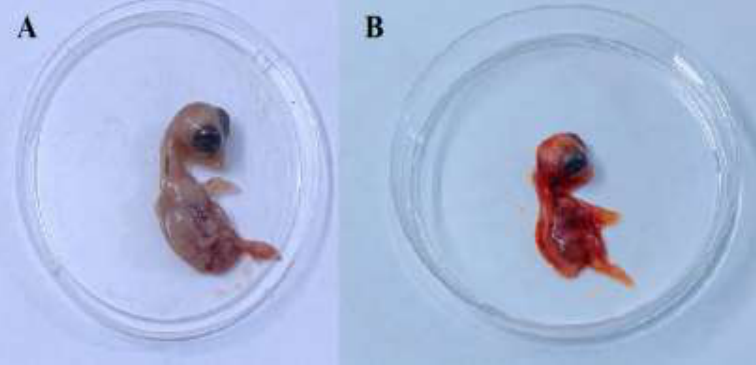
Figure 3: (A) control not infected showing no alterations compared to (B) Skin hemorrhage in chicken Embryos after inoculation with NDV.